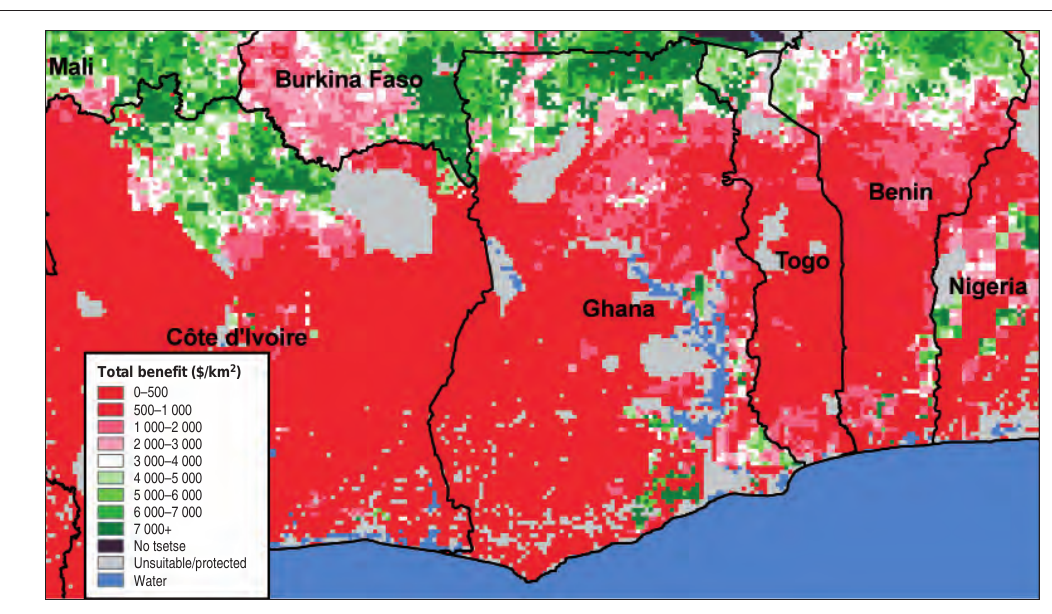
FIG. 3 Potential benefits from the removal of trypanosomosis in West Africa: US$ gained over 20 years Source: Adapted from Shaw et al. 2006 Note: Future benefits are discounted at 10 % per